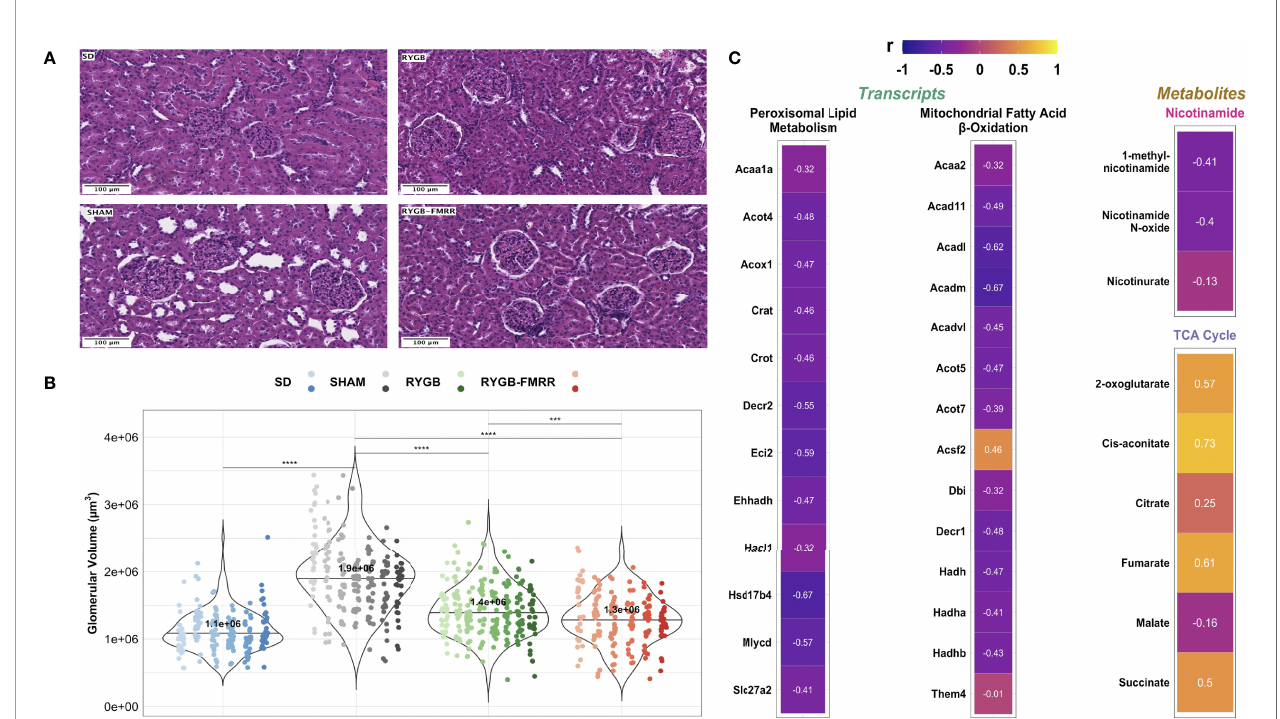
FIGURE 8 | Changes in glomerular volume and their relationship to renal cortical FAO transcripts and urinary nicotinamide and TCA cycle metabolites. (A) Representative images (20x, scale bar 100µm) of haematoxylin and eosin-stained kidney sections from the four experimental groups. (B) Glomerular volume (µm 3 ) was assessed in 30 glomeruli from 6-8 animals per group. Data are plotted as violin plots with individual glomerular measurements superimposed. Within each group, each animal is identi fi ed as its own column of dots with a unique colour shade. Median group values are identi fi ed by the horizontal black line in each violin and printed on each violin. Statistical signi fi cance of between-group differences derived from multiplicity-corrected Wilcoxon rank-sum tests is presented. Statistical signi fi cance is denoted as follows: ns = not signi fi cant; * = p <0.05; ** = p <0.01; *** = p <0.001; **** = p <0.0001. (C) Correlation plots highlighting Pearson correlation r values for glomerular volume correlations with renal cortical transcripts and urinary metabolites. Regularized log-transformed gene expression counts were used for gene-structure correlations. Transcripts plotted are those which resulted in enrichment of peroxisomal and mitochondrial lipid metabolism pathways in RYGB-FMRR rats (also highlighted in the circular network plot in Figure 2D ). PQN-normalized urinary 1 H-NMR peaks from samples obtained at 4 weeks after intervention were used for metabolite-structure correlations. Metabolites involved in nicotinamide metabolism (PPAR a biomarkers) and TCA cycle intermediates, many of which were differentially abundant between RYGB-FMRR and RYGB rats, are plotted. Individual cells in the correlation plots are scaled by colour indicating strength and directionality of the correlation. PPAR a , peroxisome proliferator- activated receptor-alpha; RYGB, Roux-en-Y gastric bypass; RYGB-FMRR, Roux-en-Y gastric bypass plus feno fi brate, metformin, ramipril, and rosuvastatin; SD, Sprague Dawley; SHAM, sham surgery (laparotomy); TCA, tricarboxylic